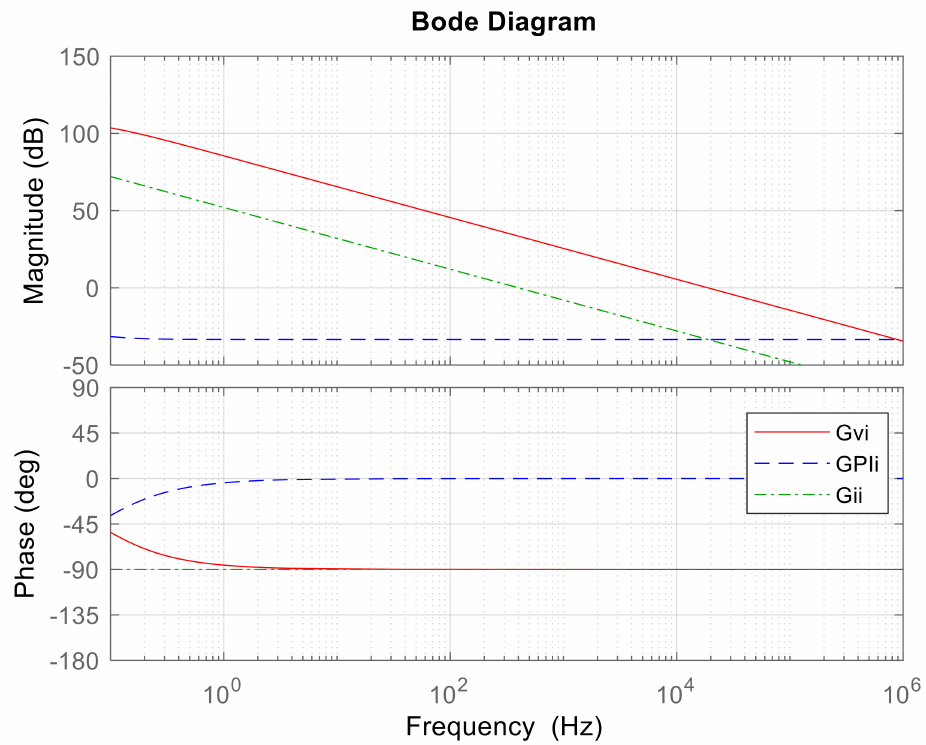
Figure A4. Bode plots of the inner current-control loop